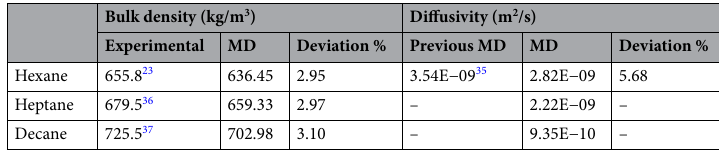
Table 1. Comparison of simulation values to existing literature